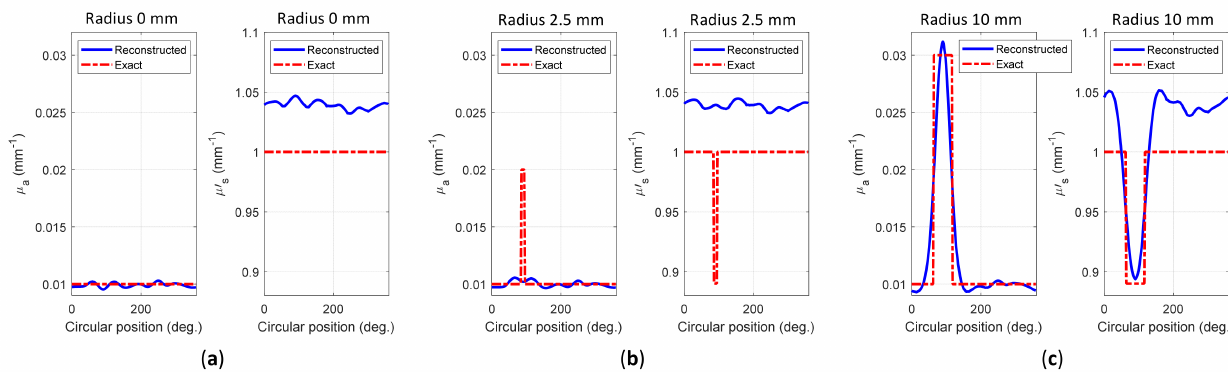
Figure 11. Circular profile of case A1 for ( a ) homogeneous, ( b ) invisible inclusion, and ( c ) visible inclusion.